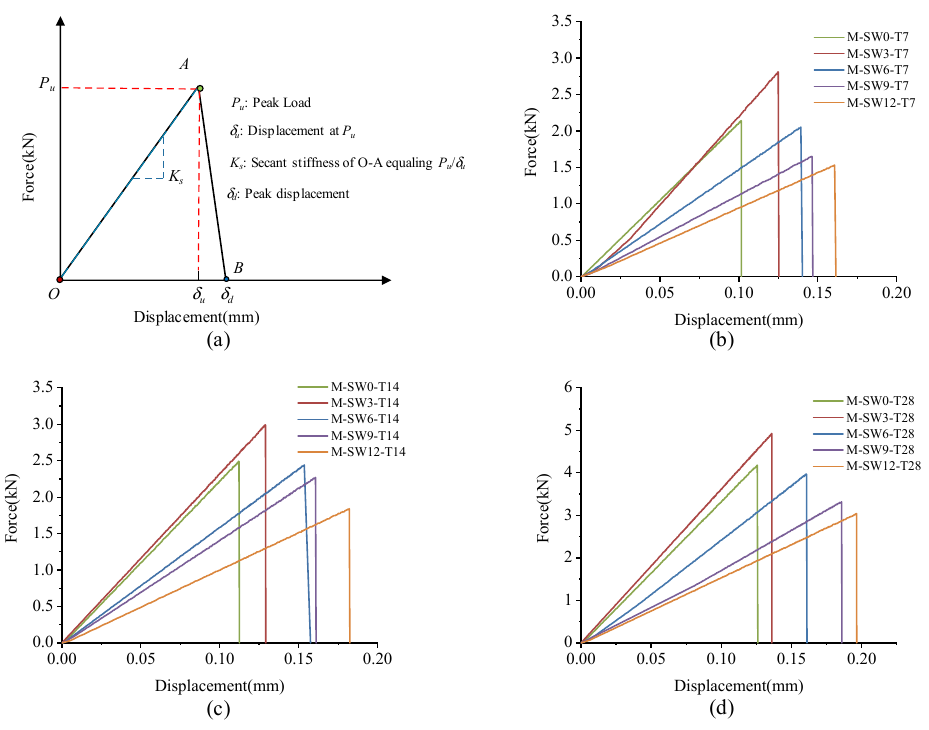
Figure 8. L-D curve of specimens. ( a ) L-D curve configuration; ( b ) T7; ( c ) T14; ( d ) T28. As mentioned earlier, specimens in Group T7 increased their loading load to the peak point (point A) in an approximately linear way, and then dropped it sharply to point B.